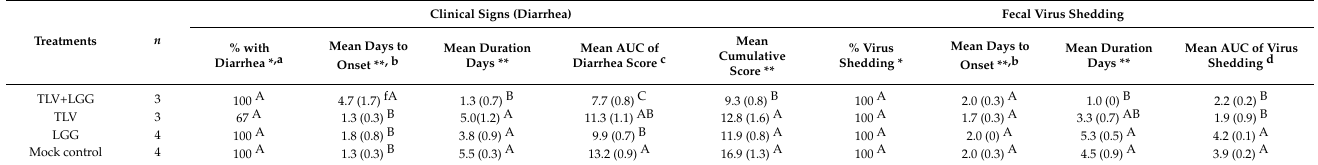
Table 2. Clinical signs and rotavirus fecal shedding in Gn pigs after virulent Wa human rotavirus (HRV)